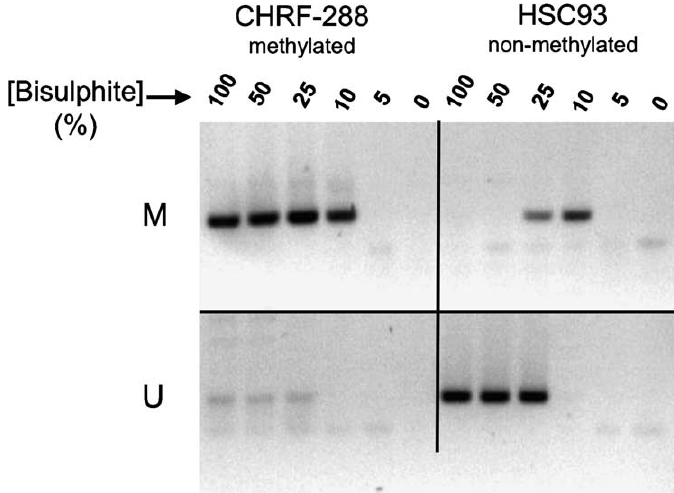
Fig. 1. Bisulphite concentration-dependent variation in results obtained by MSP. MSP carried out on DNA isolated from FANCF- methylated CHRF-288 cells, and from unmethylated HSC93 wild type control cells (both formalin-fixed and paraffin embedded), after treatment with various concentrations of sodium bisulphite. An amplification product was generated with the M primers using methylated DNA even when the bisulphite concentration was down to 10% of the prescribed concentration (EZ DNA methylation kit, Zymo research). Using unmethylated DNA as a template, the PCR does not generate an amplification product when reducing the bisulphite concentration to 50%. Unmethylated DNA treated with 10% and 25% of the prescribed concentrations of sodium bisulphite, however, appeared to produce a PCR product with the M primers that will be interpreted as methylation-positive, but in fact is false-positive and due to suboptimal bisulphite treatment of the